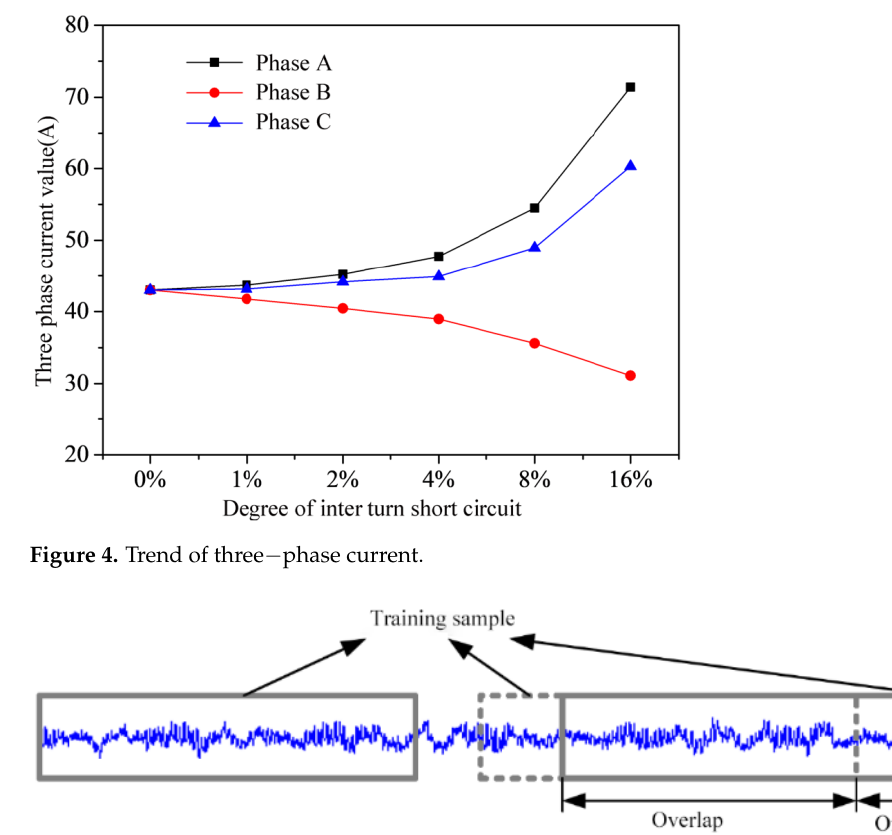
Figure 5. Data enhancement method.